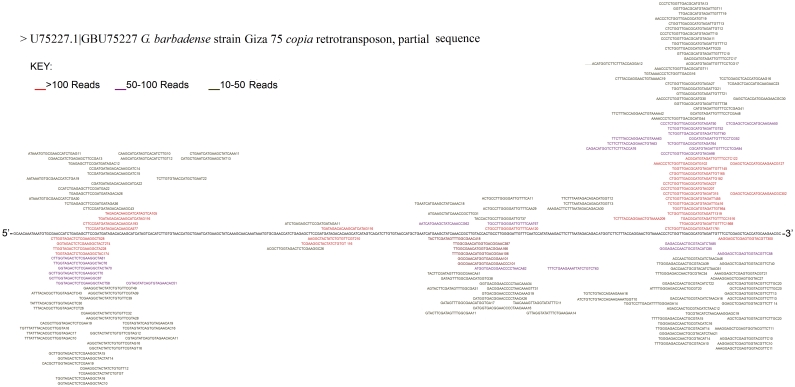
The small RNAs with a perfect match to U75227.1|GBU75227 G. barbadense strain Giza 75 copia retrotransposon.The color represents abundance of the sequences.